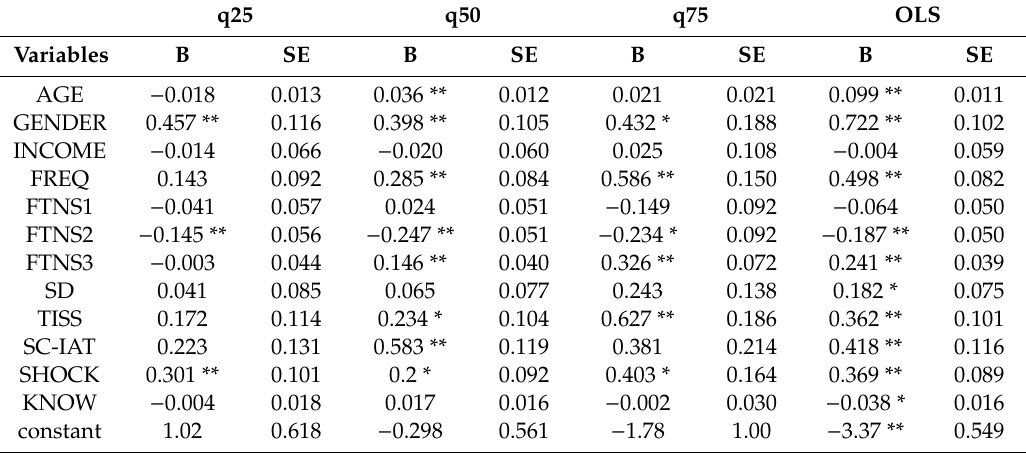
Table 5. OLS and quantile regressions for the enriched tomatoes ( n = 1000).